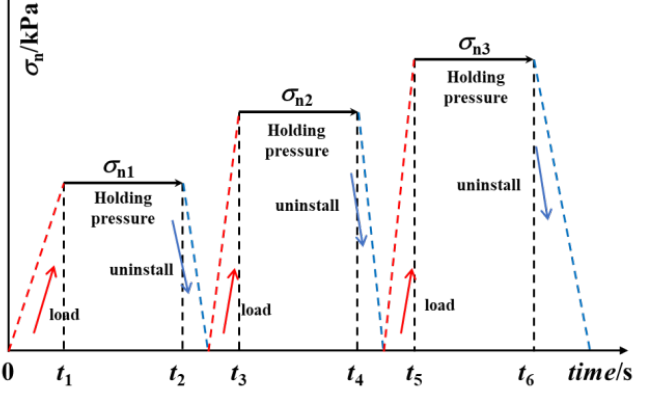
Figure 7. Repeated multi-stage loading and unloading of variable normal stress.